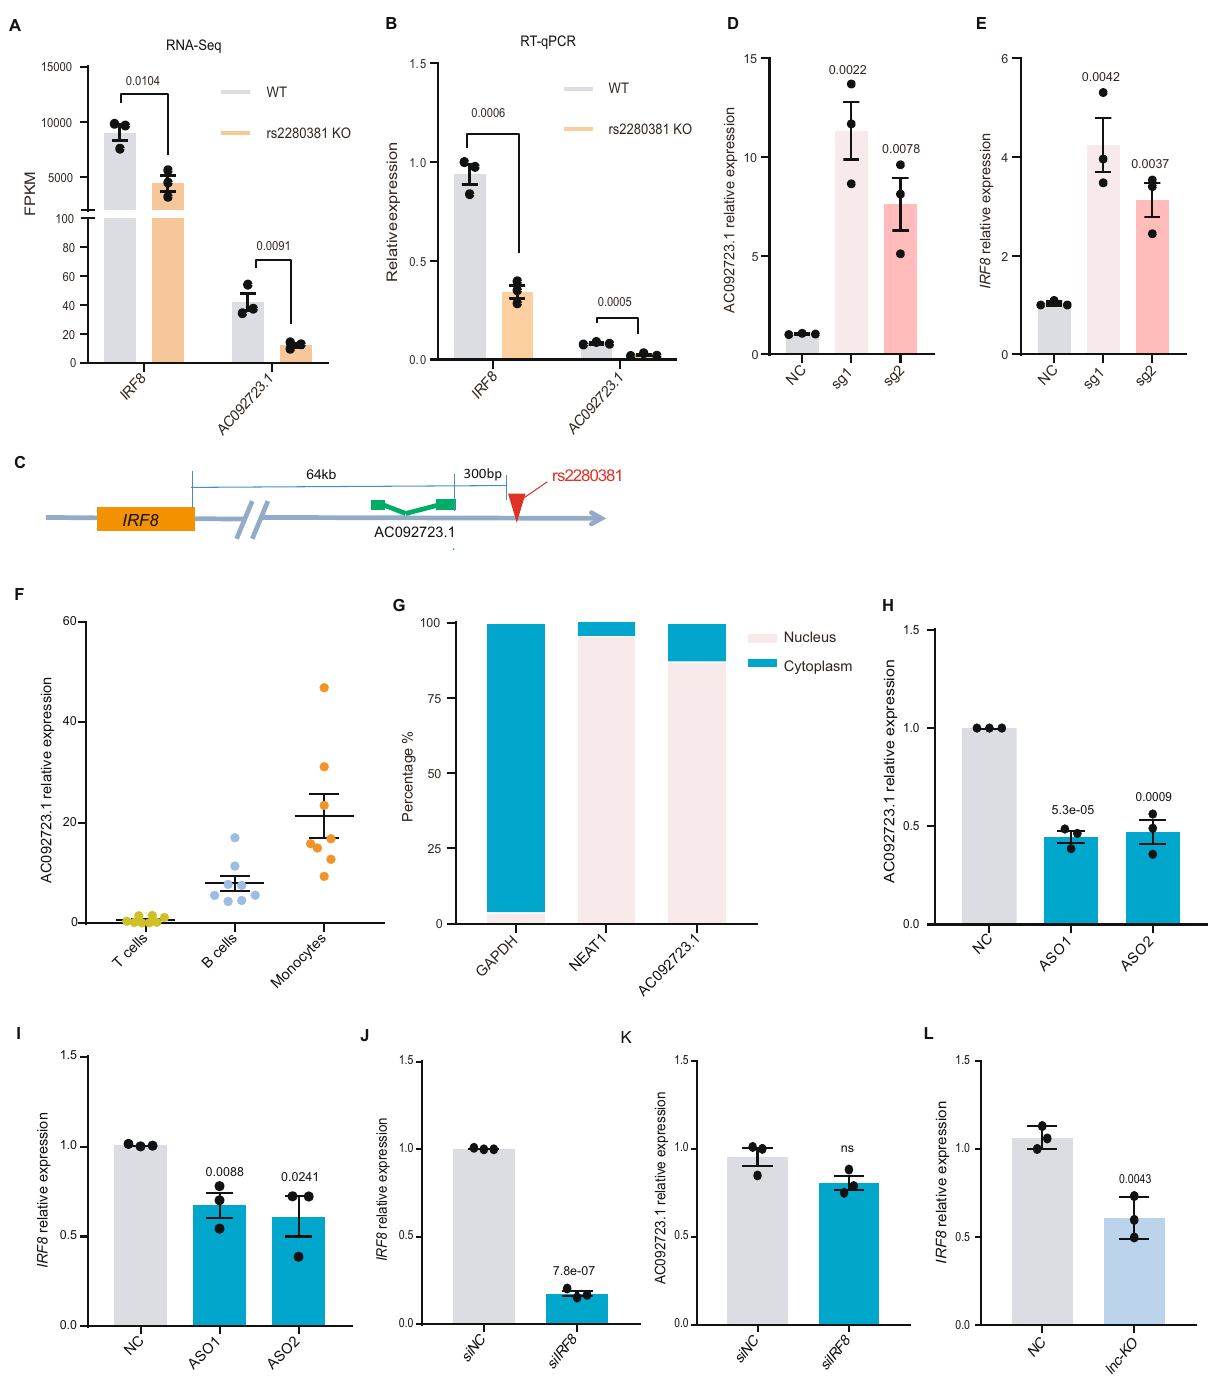
Fig. 3 AC092723.1 mediates the effect of the rs2280381-containing region on IRF8 expression. A , B RNA-sequencing and RT-qPCR analysis of the expression of IRF8 and AC092723.1 in U-937 WT clones and KO clones ( n = 3, biologically independent samples). WT: rs2280381 wildtype, KO: 138 bp fragment containing the rs2280381 deletion. C The relative location of rs2280381, AC092723.1, and IRF8 . D , E CRISPR SAM assay increases AC092723.1 and IRF8 expression by targeting the rs2280381-containing region using speci fi c gRNA in U-937 cells ( n = 3, biologically independent experiments). F AC092723.1 expression in different human immune cell subpopulations as measured by RT-qPCR ( n = 8, biologically independent samples). G RT-qPCR analysis of AC092723.1 abundance in nuclear and cytoplasmic fractions of primary monocytes. GAPDH , cytoplasmic marker. NEAT1, nuclear marker. H , I RT-qPCR analysis of AC092723.1 and IRF8 expression with or without AC092723.1 knockdown in primary monocytes ( n = 3, biologically independent experiments). J , K RT-qPCR analysis of AC092723.1 and IRF8 expression with or without IRF8 knockdown in primary monocytes ( n = 3, biologically independent experiments). L RT-qPCR analysis of IRF8 expression after deletion of a partial region of AC092723.1 by CRISPR-Cas9 ( n = 3, biologically independent experiments). Data are represented as mean ± SEM, and p values are calculated using an unpaired two-tailed Student ’ s t test. ns not signi fi cant. See also Supplementary Fig.